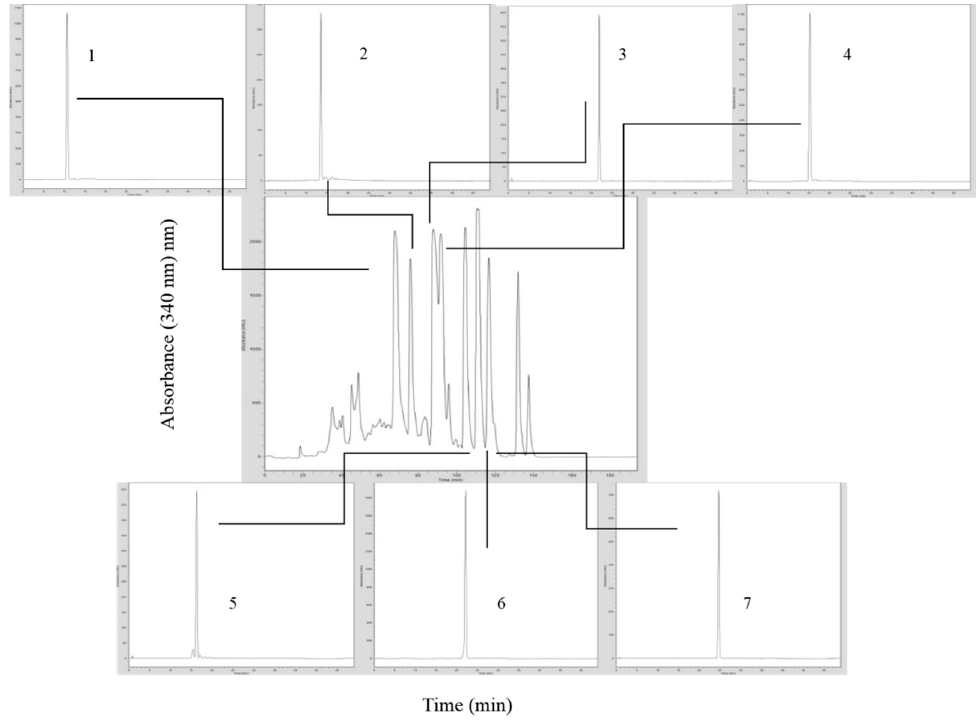
Figure 1. HPLC-UV/DAD chromatogram of crude extract from kino of Corymbia torelliana . UV trace of crude extract (with UV spectra of each major